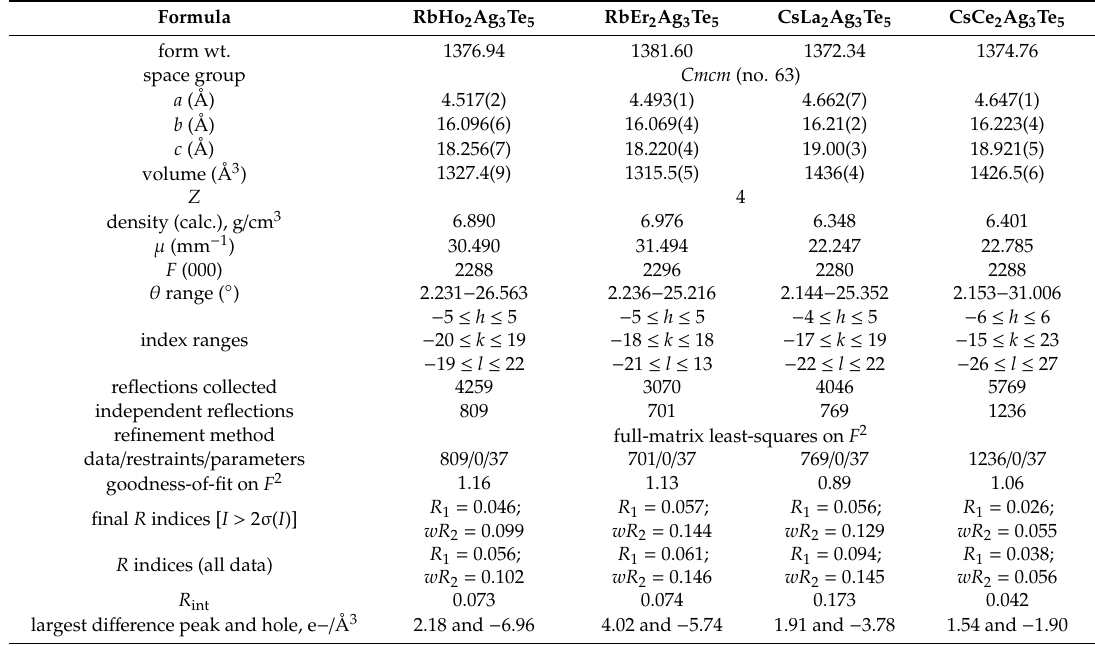
Figure 2. Overview of the unit-cell volumes of the herein and previously reported [18,28] ALn 2 Ag 3 Te 5 - Table 1. Details of the crystal structure investigations and refinements of RbLn 2 Ag 3 Te 5 (Ln = Ho, Er) and CsLn 2 Ag 3 Te 5 (Ln = La, Ce).